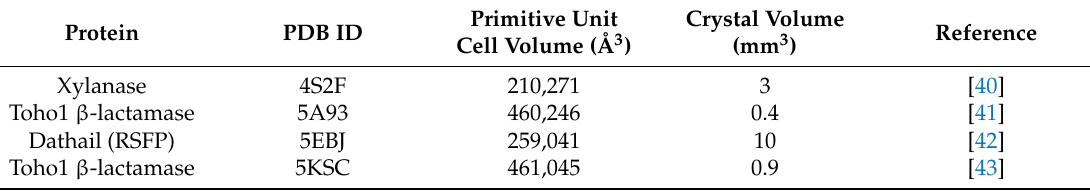
Table 5. Protein structure solved using the MaNDi instrument. IPP, Inorganic Pyrophosphatase. LPMO, lyric polysaccharide monooxygenase. AAC, aminoglycoside acetyltransferase. MnSOD, manganese superoxide dismutase. FMO, Fenna-Matthews-Olson complex. RSFP, reversibly switchable fluorescent protein. CA-EZM, carbonic anhydrase in complex with ethoxzolamide. CA-DZM, carbonic anhydrase in complex with